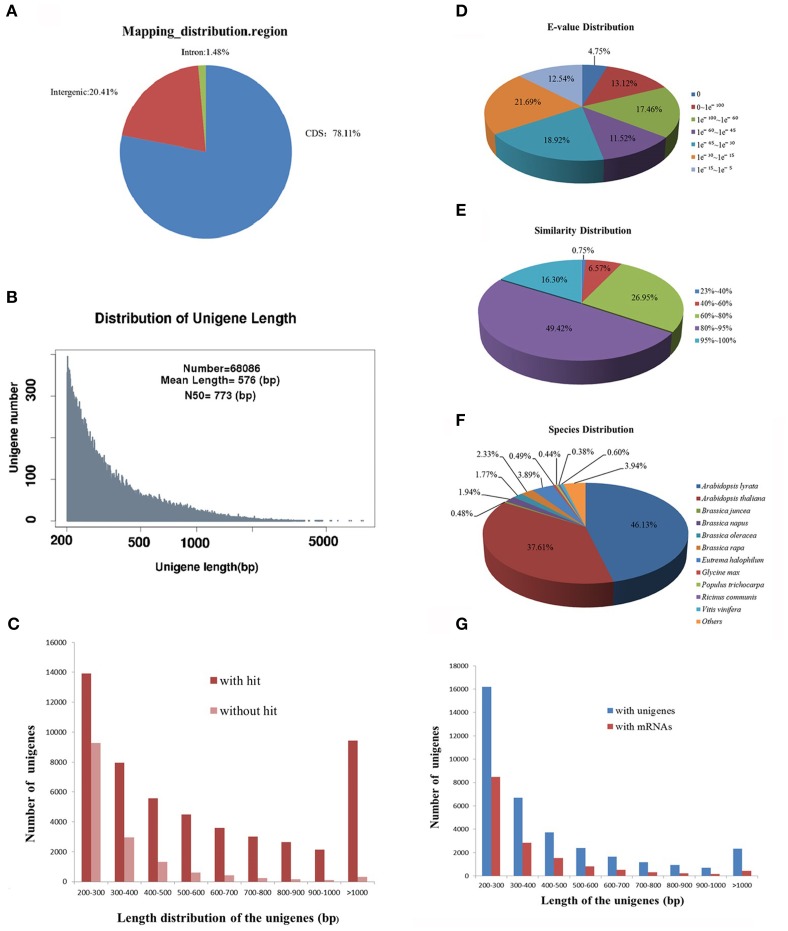
Sequencing, de novo assembly and annotation of leaf transcriptome of R. sativus transcriptome. (A) The clean reads distribution map of leaf tissue on B. rapa genome. (B) The de novo assembly result of leaf transcriptome. (C) Comparative analysis of unigenes length with or without hit against Nr and Swissprot databases. (D)
E-value distribution of BLAST hits for each unique sequence against the Nr database. (E) Similarity distribution of the top BLAST hits for each sequence against the Nr database. (F) Species distribution is shown as a percentage of the total homologous sequences against the Nr database. (G) Comparative analysis of the leaf unigenes with the unigene and mRNA databases of R. sativus.